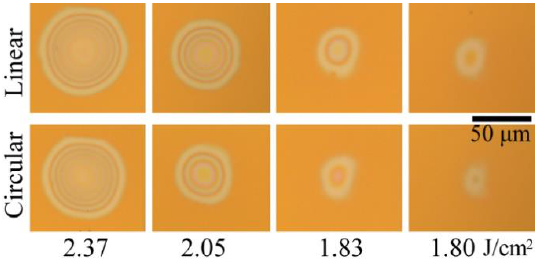
Figure 4. Typical damage morphology under linearly and circularly polarized lasers at 1-on-1.